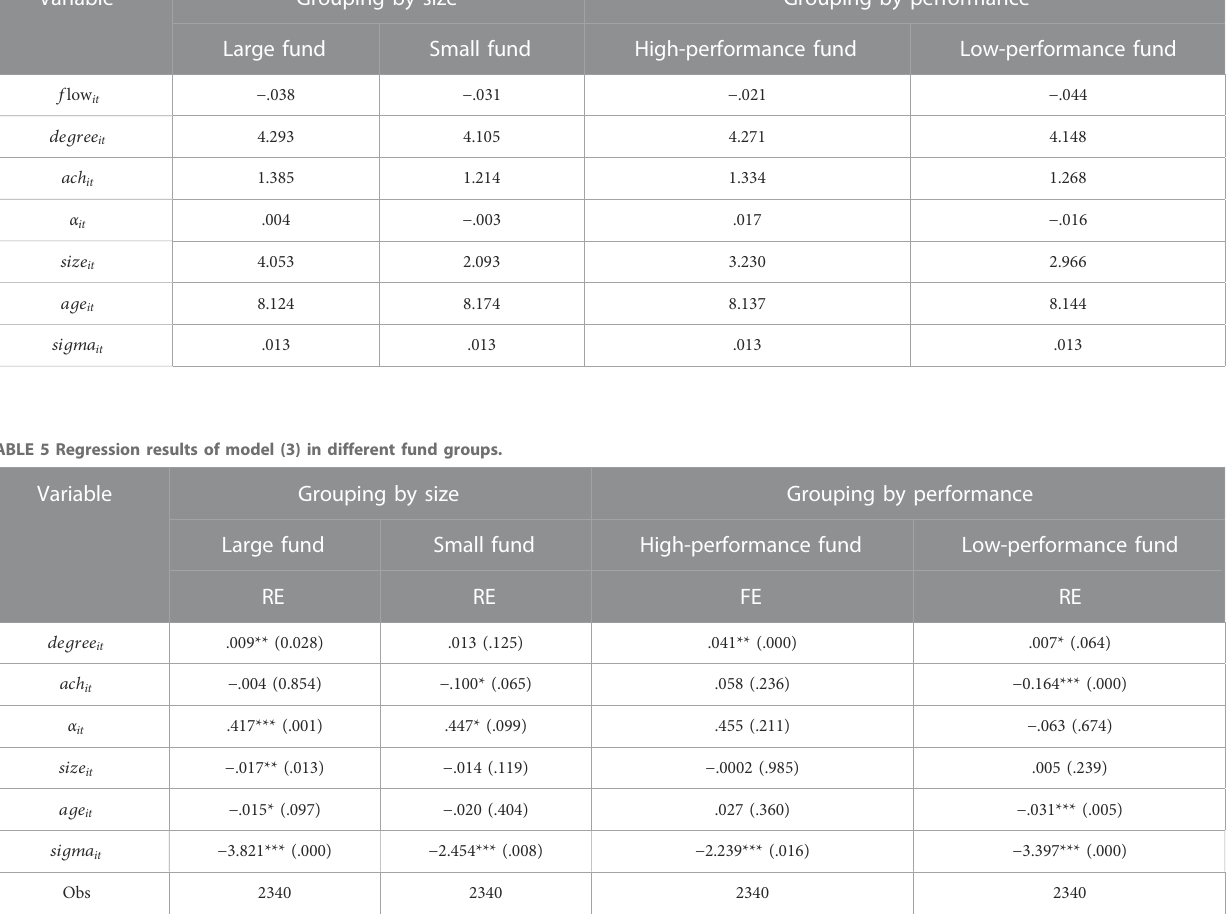
TABLE 4 Descriptive statistics of variables of heterogeneity analysis. Variable Grouping by size